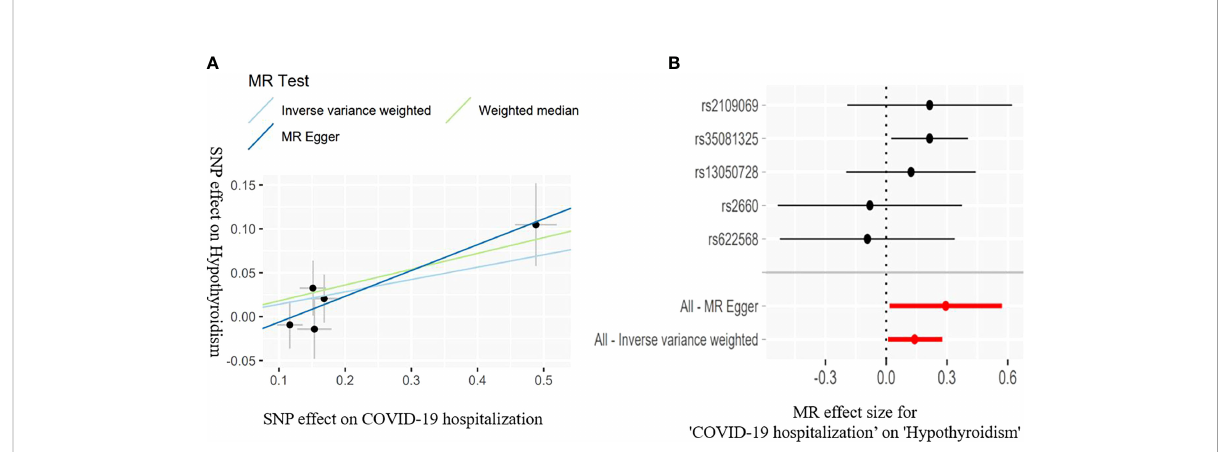
FIGURE 3 Scatter plots (A) for estimating causal effects of genetically predicted susceptibility on risk of hypothyroidism. Each black point representing the effect sizes of each SNP on the exposure (horizontal axis) and on the outcome (vertical axis) is plotted with error bars corresponding to each standard error (SE). The slope of each line corresponds to the combined estimate using each method of the IVW (light blue line), the MR-Egger regression (blue line), and the weighted median (light green line). Forest plots (B) of susceptibility on the risk of hypothyroidism; the red points showed the combined causal estimate using all SNPs together in a single instrument, using two different methods (MR-Egger and IVW).